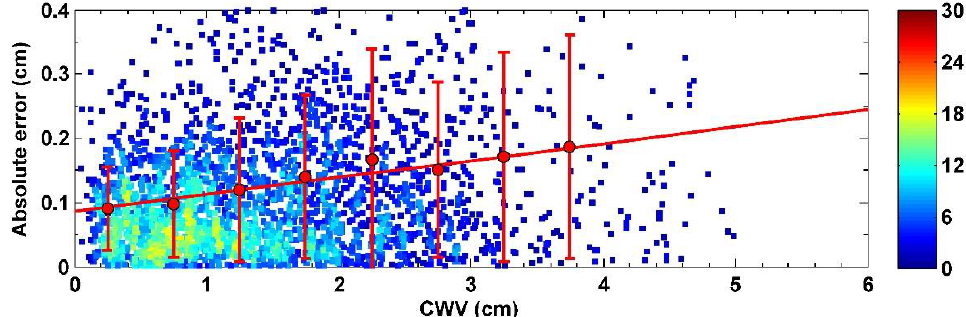
Figure 7. The distribution of the absolute error of PSAC CWV retrieval results from March 2021 to August 2021. The sloping red line is the linear regression line. The red points are the means for specific ranges of absolute error, and the vertical red lines are the mean ±2σ (standard deviation) of absolute error in a certain range. The color of a point is determined by the density of the point where it is located.